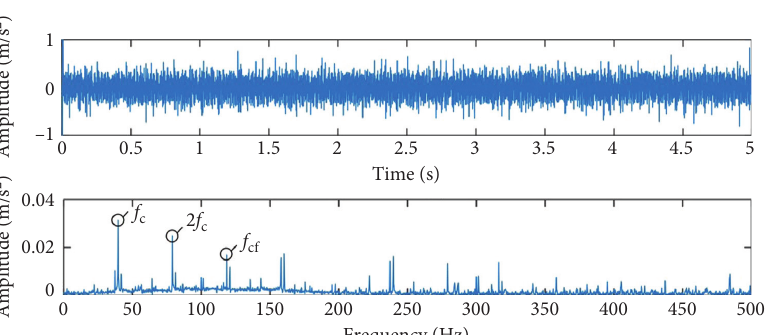
Figure 10: Signal processed by